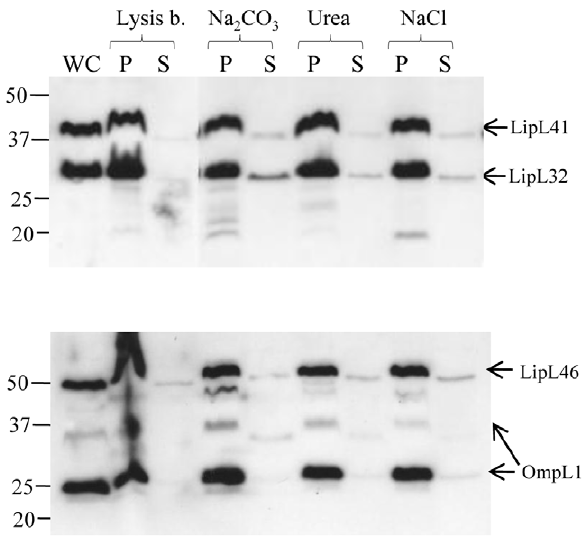
Figure 5. Membrane affinity analysis of LipL32, LipL41, LipL46 and OmpL1. The membrane fraction of L. interrogans was treated with lysis buffer as a control or 0.1 M Na 2 CO 3 (pH 11), 1.6 M urea, or 0.6 M NaCl for 15 min at 4 u C. Samples were pelleted by centrifugation